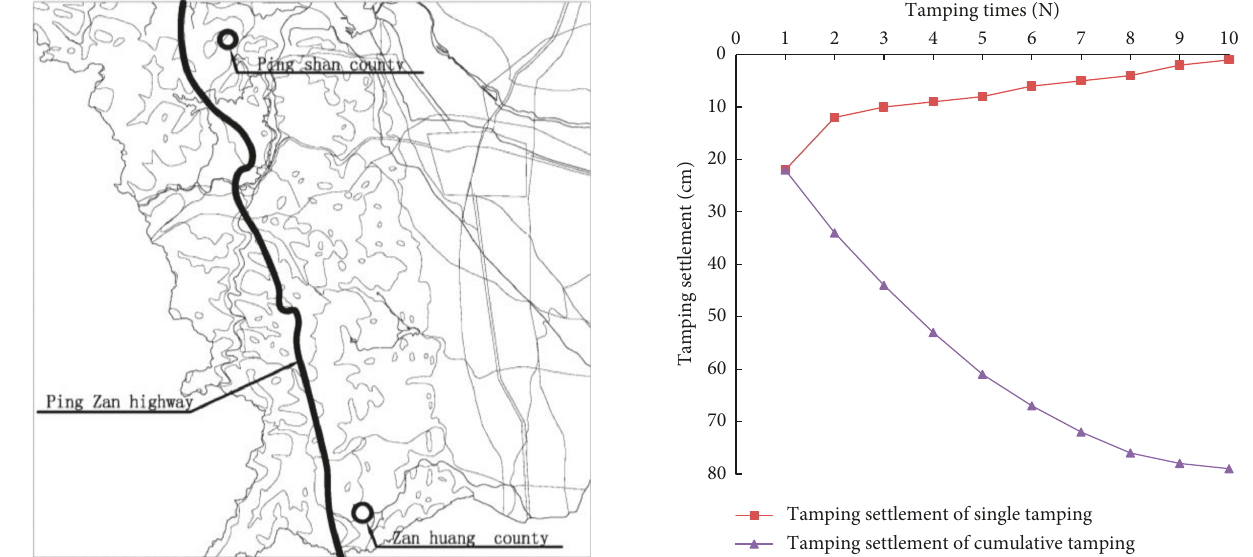
Figure 1: The route of the Ping-Zan highway.